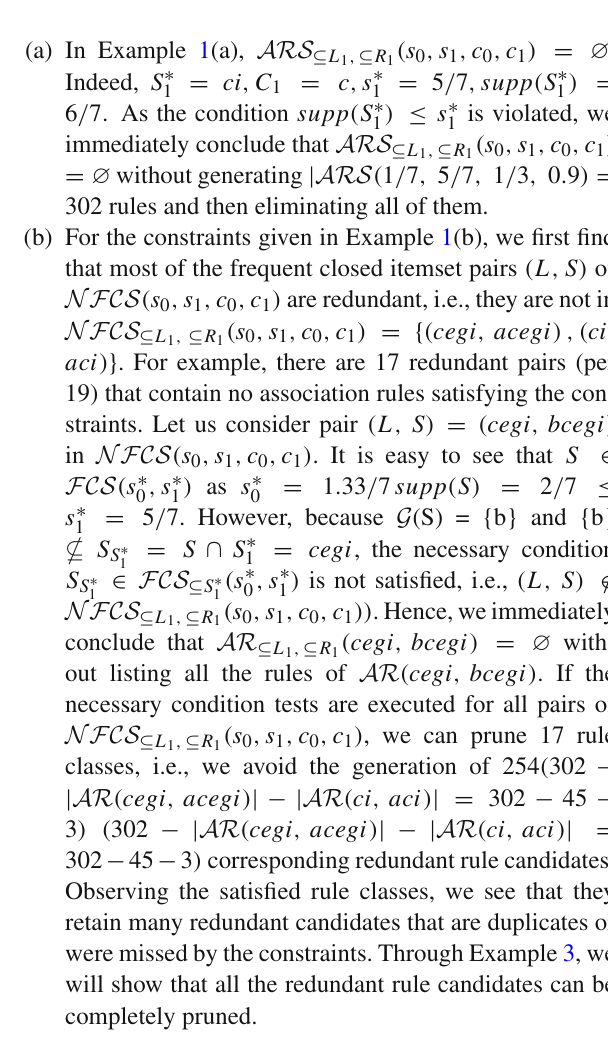
Fig. 2 The MFCS _ FromLattice